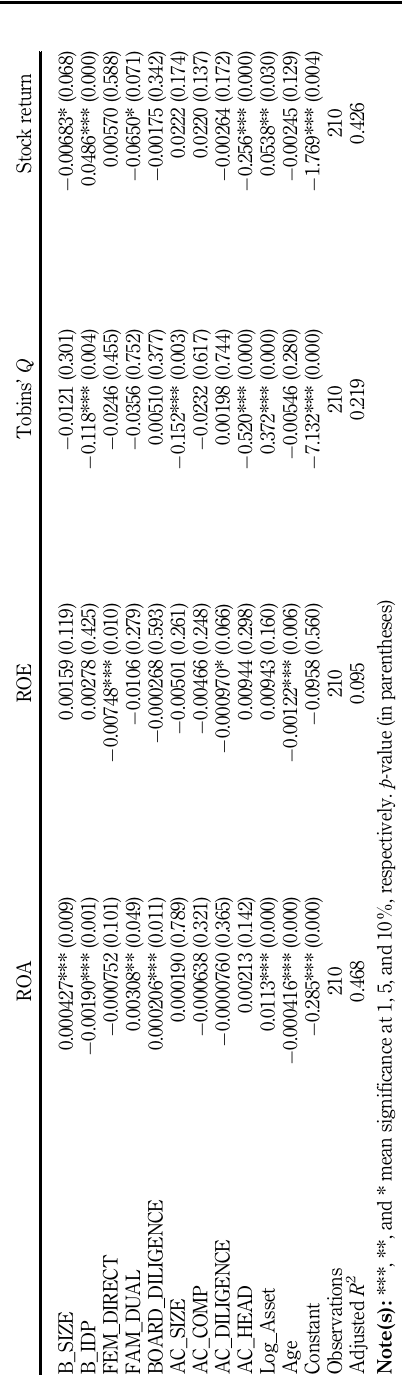
Table 3. Regression